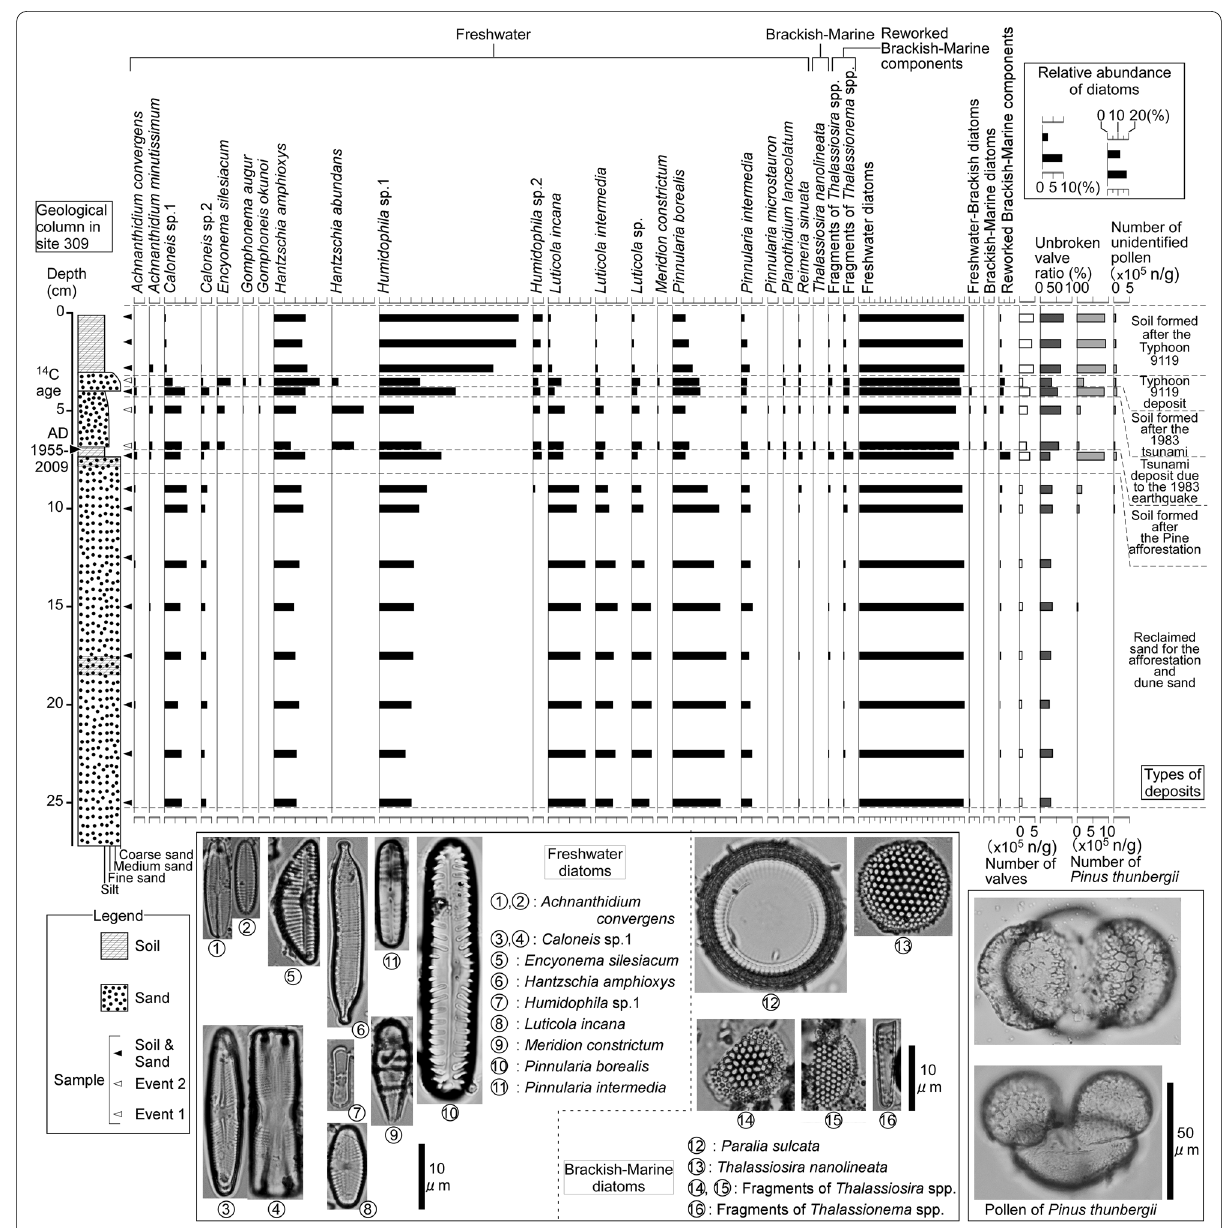
Fig. 7 Results of diatom and pollen analysis of core samples from site